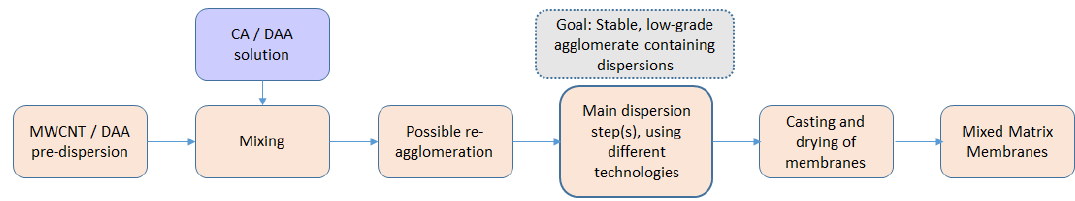
Figure 1. Schematic representation of the intermediate steps to be produced mixed matrix membranes (MMMs).